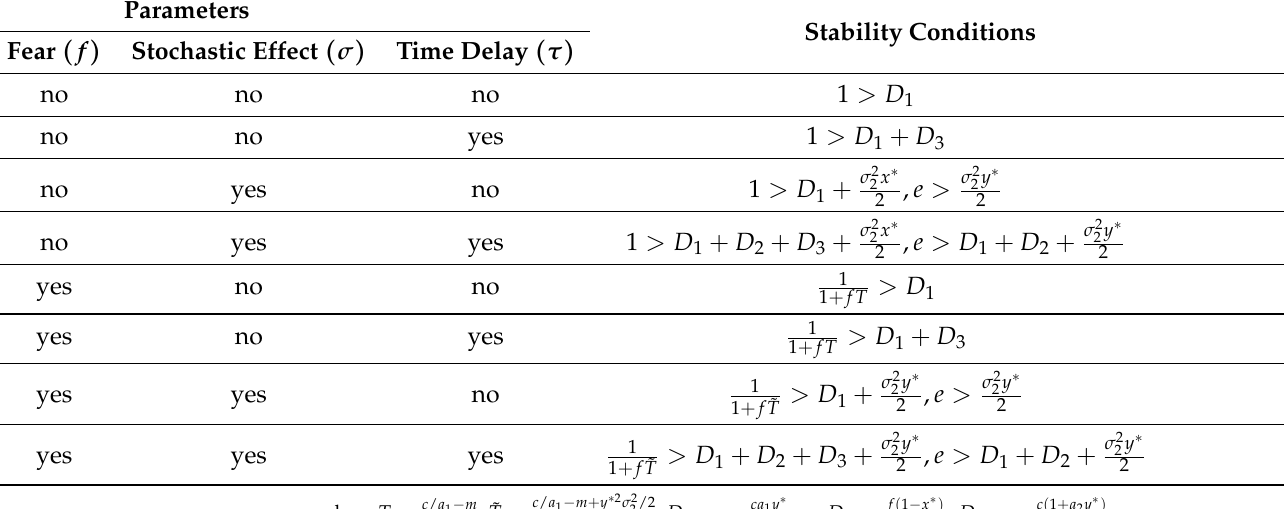
Table 4. Stability conditions of the equilibrium points E ∗ ( x ∗ , y ∗ )